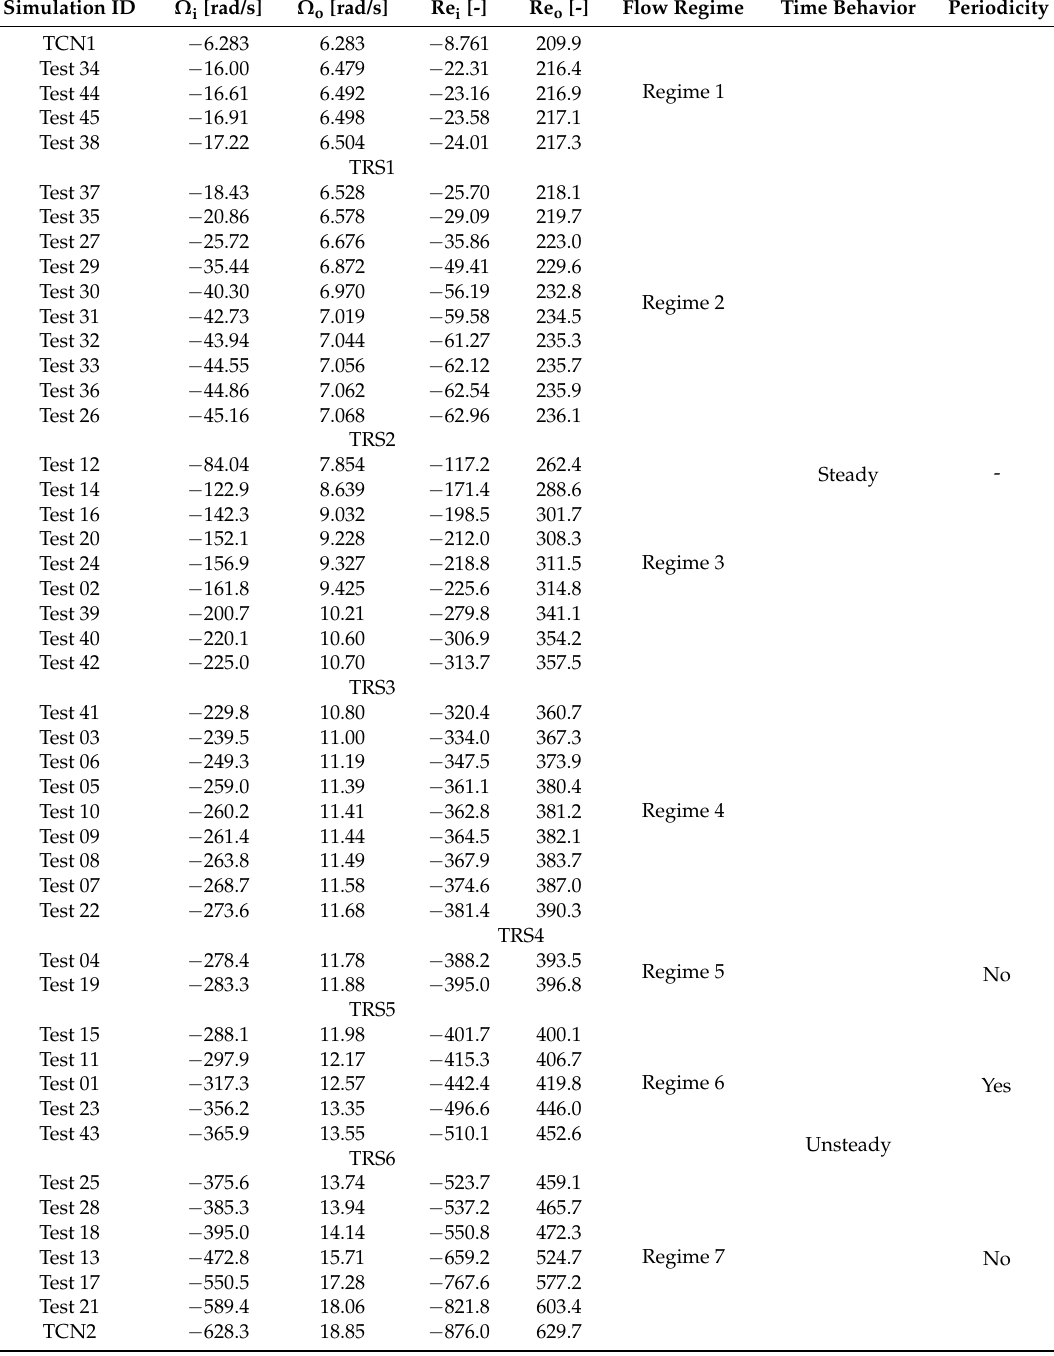
Table 4. Matrix of the tests performed for the identification of flow